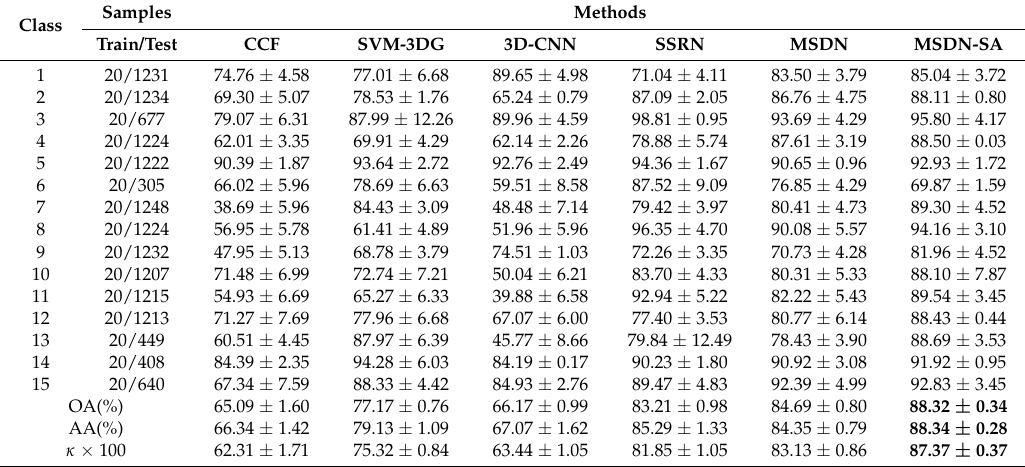
Table 4. Network architecture details of proposed MSDN-SA for University of Houston Dataset.